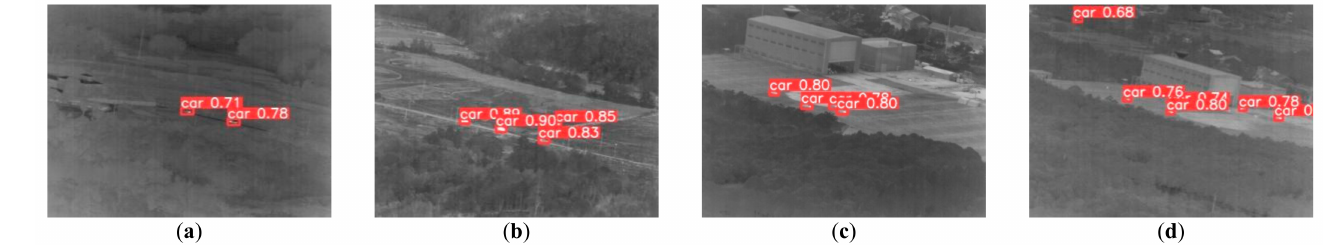
Figure 25. Dense + Ghost + SE detection diagram. ( a ) Scene 1. ( b ) Scene 2. ( c ) Scene 3. ( d ) Scene